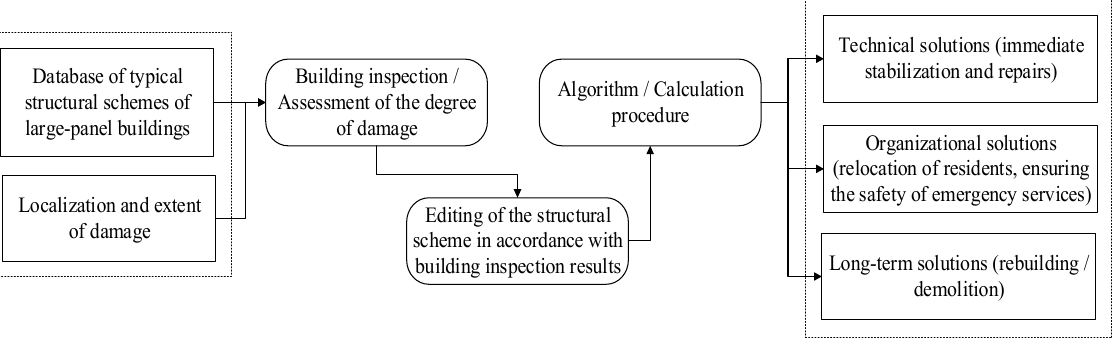
Figure 6. Procedure of war damage assessment of and decision-making for the large-panel building.